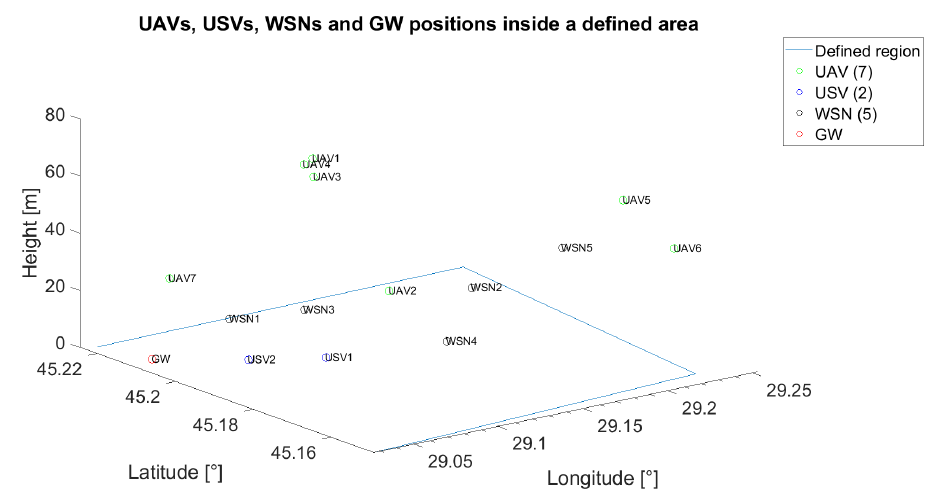
Figure 14. Initial positions. Scenario depicted in Table 14, ρ = 0.2. The corresponding initial communication graph is given in Figure 15.